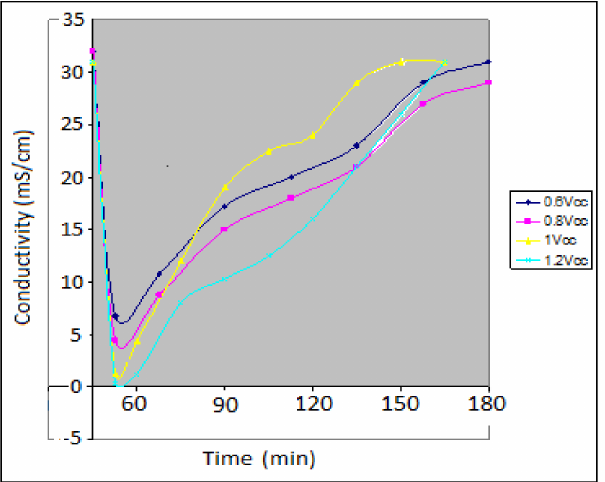
Figure 23. Variation of the ionic conductivity of the artificial sea water test solution during the charge